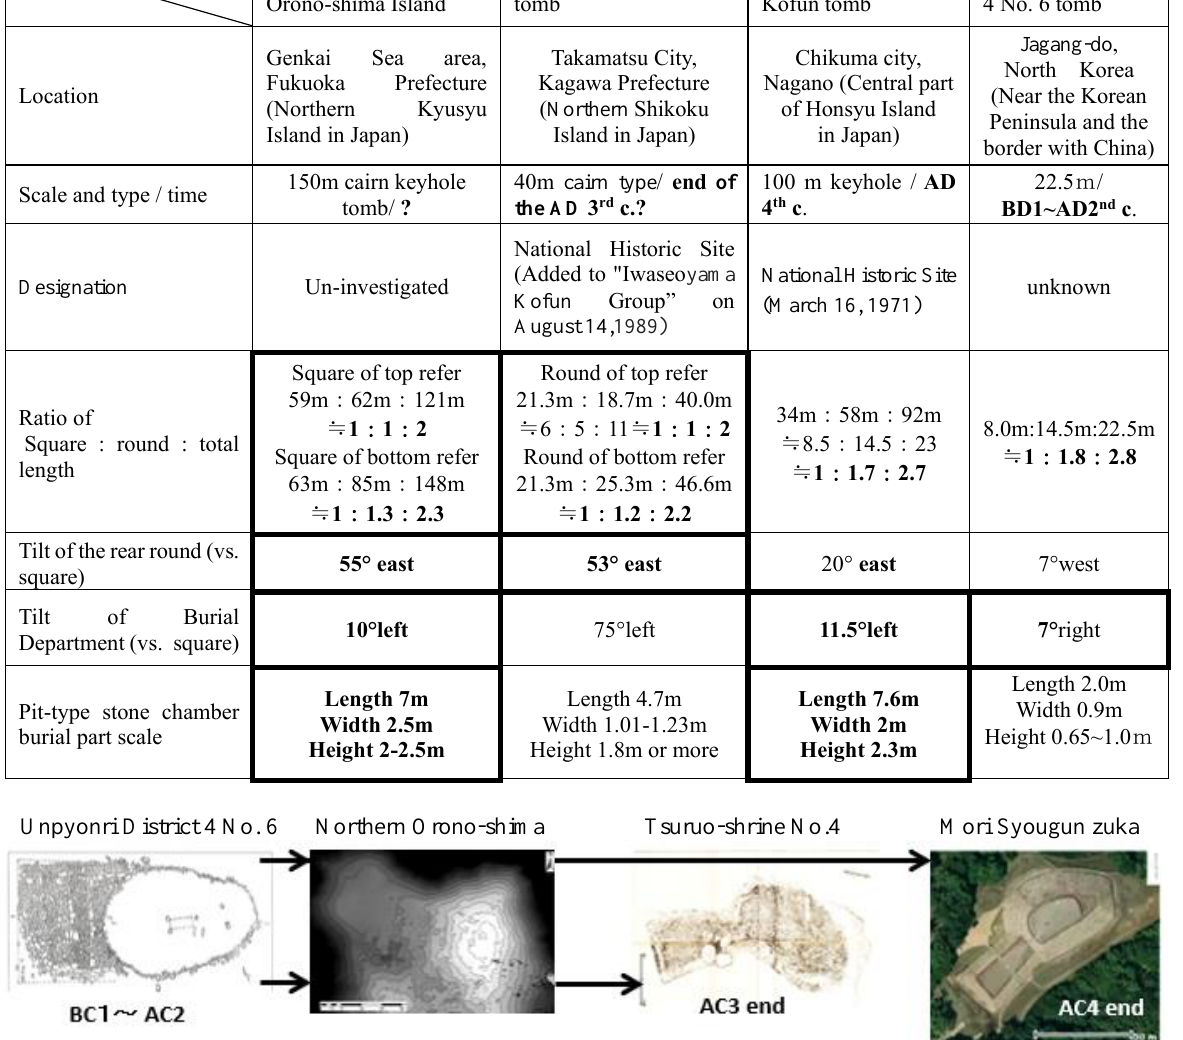
Fig.13 Expected shape change of cairn tomb from Korea to